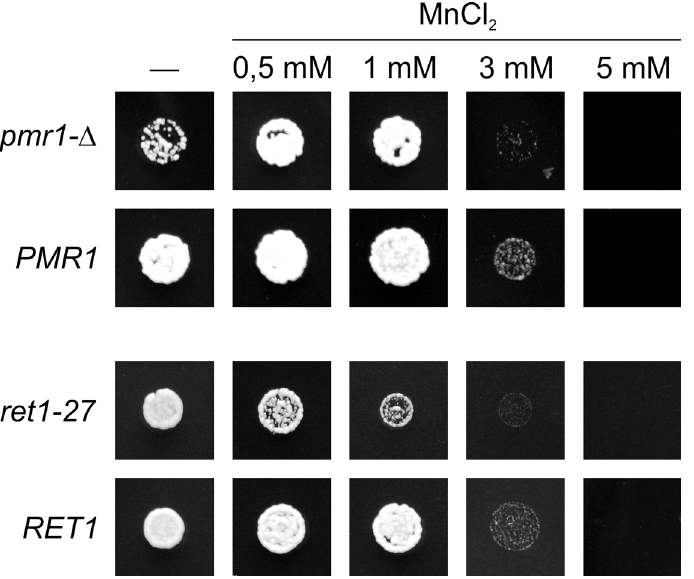
Fig 1. Growth of the pmr1- Δ and ret1-27 mutants on SD * medium supplemented with different concentrations of MnCl 2 . Cell suspensions with equal densities were spotted onto corresponding media and grown for 2 days. The experiment was performed using serial dilutions of cell suspensions (S3 Fig) and a representative dilution is shown in this figure. pmr1- Δ , a subclone of the 1MA27/12/GP1 strain lacking the PMR1 containing plasmid; the PMR1 , 1MA27/12/GP1 strain, ret1-27 , the 64MA70QAL strain; RET1 , the 64MA70QA-RET